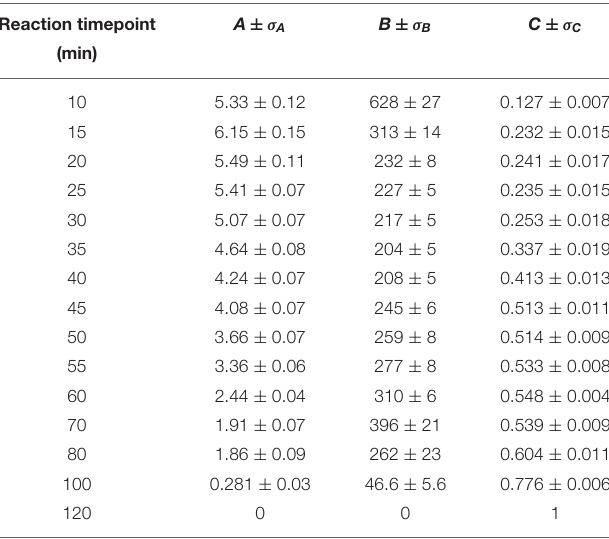
TABLE 1 | Best-fit values for parameters A , B , and C with one standard deviation error of the fitted variables ( σ X ). Reaction